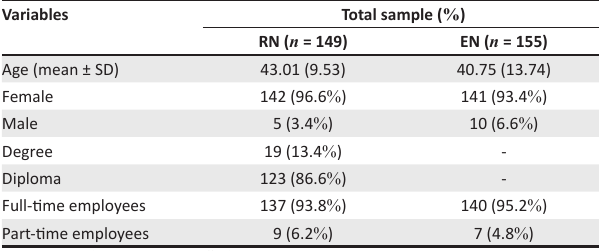
TABLE 2: Demographic characteristics of the participants ( N = 304).